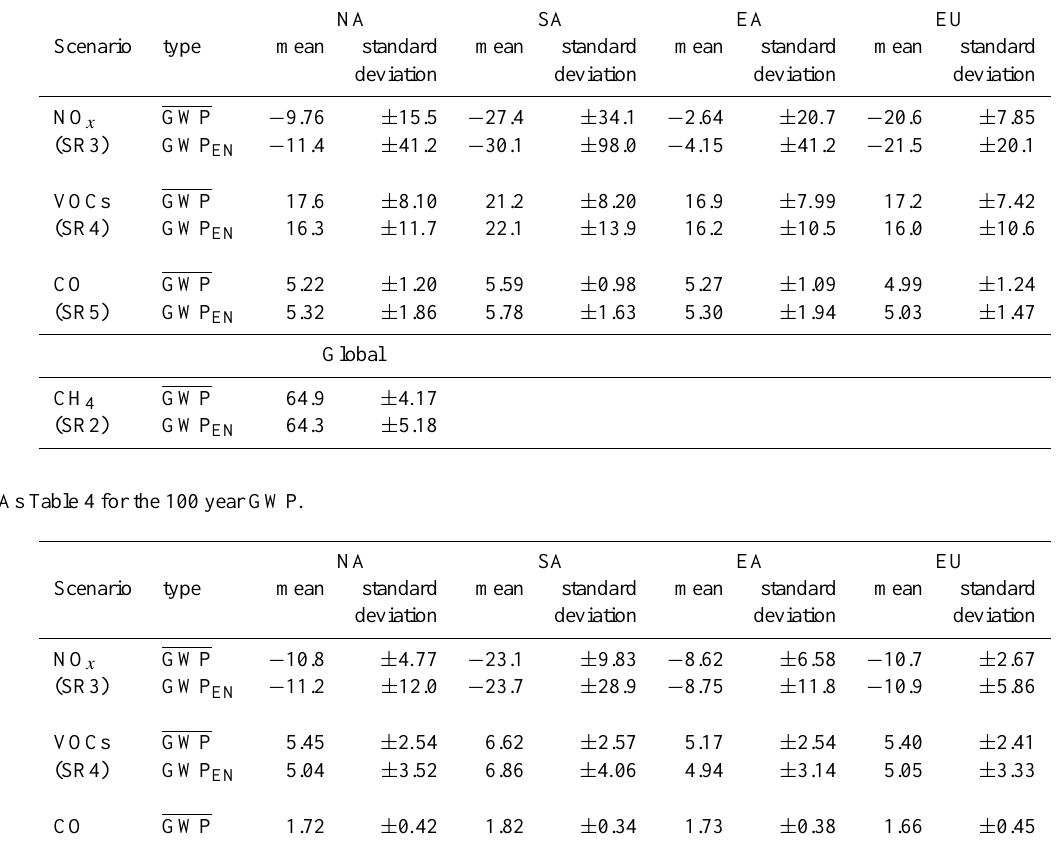
Table 4. Ensemble-mean 20 year GWP. The true mean GWP is denoted GWP. The GWP calculated using the method described in Fry et al. (2012) is denoted GWP EN . Average methane lifetimes used in the metric construction are given in Table 2. NA